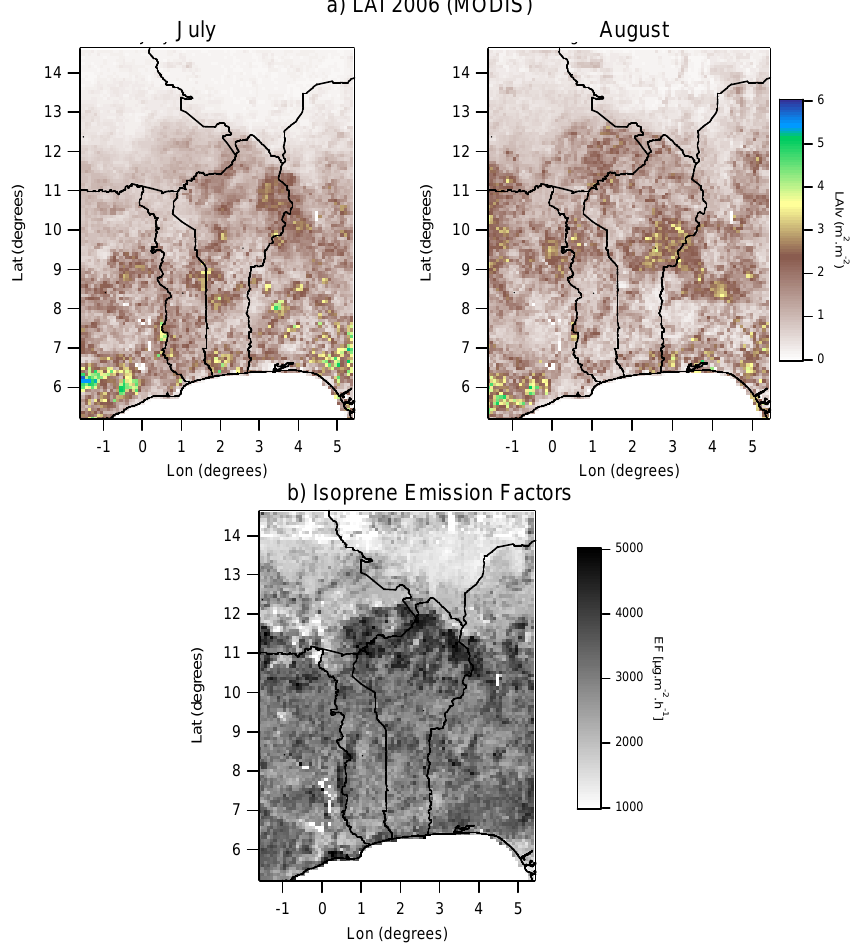
Figure 6 – Spatial distribution of LAIv data from MODIS (2006) (a), and the isoprene emissions factors for the 9 km horizontal resolution domain (b). Fig. 6. Spatial distribution of LAIv data from MODIS (2006) (a) , and the isoprene emissions factors for the 9km horizontal resolution domain (b)